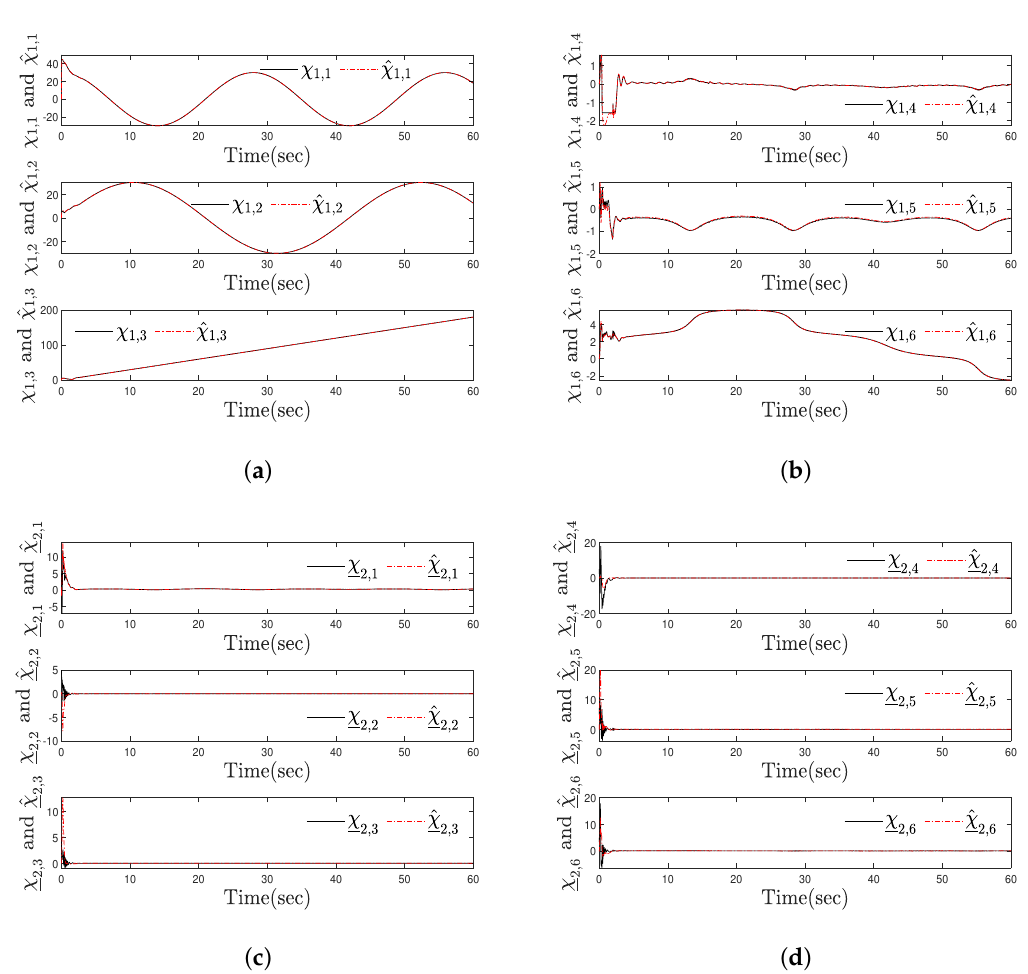
Figure 4. State estimation results of the proposed approach for Scenario 1 ( a ) χ 1,1 , ˆ χ 1,1 , χ 1,2 , ˆ χ 1,2 , χ 1,3 and ˆ χ 1,3 ( b ) χ 1,4 , ˆ χ 1,4 , χ 1,5 , ˆ χ 1,5 , χ 1,6 and ˆ χ 1,6 ( c ) χ 2,1 , ˆ χ 2,1 , χ 2,2 , ˆ χ 2,2 , χ 2,3 and ˆ χ 2,3 ( d ) χ 2,4 , ˆ χ 2,4 , χ 2,5 , ˆ χ 2,5 , χ 2,6 and ˆ χ 2,6 .